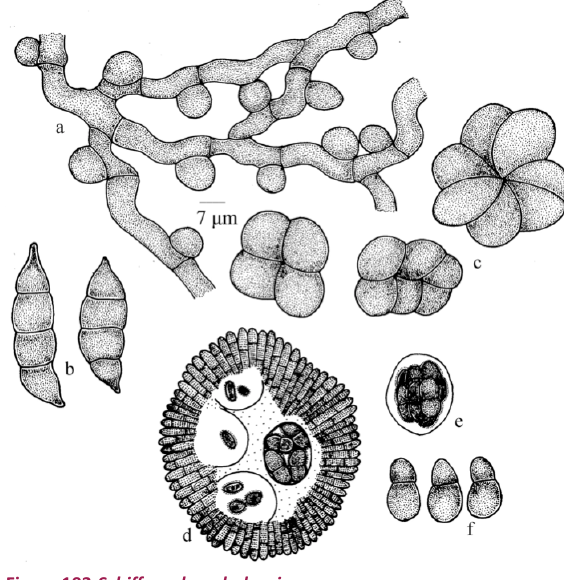
Figure 193. Schiffnerula palodensis a - Appressoriate mycelium; b - Conidia of Questieriella ; c - Conidia of Sarcinella ; d - Thyriothecium; e - Ascus; f - Ascospores